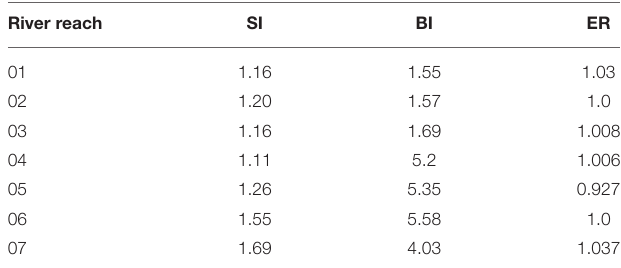
TABLE 1 | Sinuosity, braided index and entrenchment ratio values of Rambiara